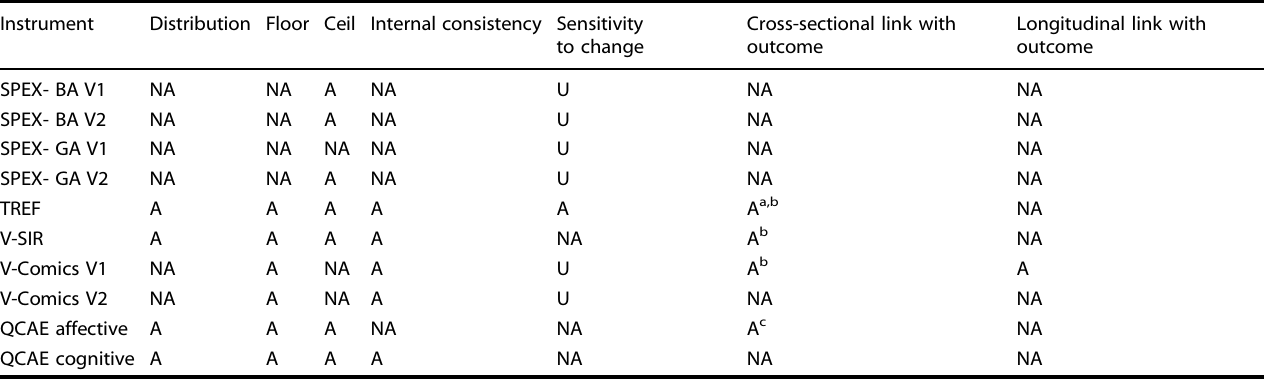
Table 4. Synthesis of the psychometric properties of each tool used in the EVACO battery. Instrument Distribution Floor Ceil Internal consistency Sensitivity